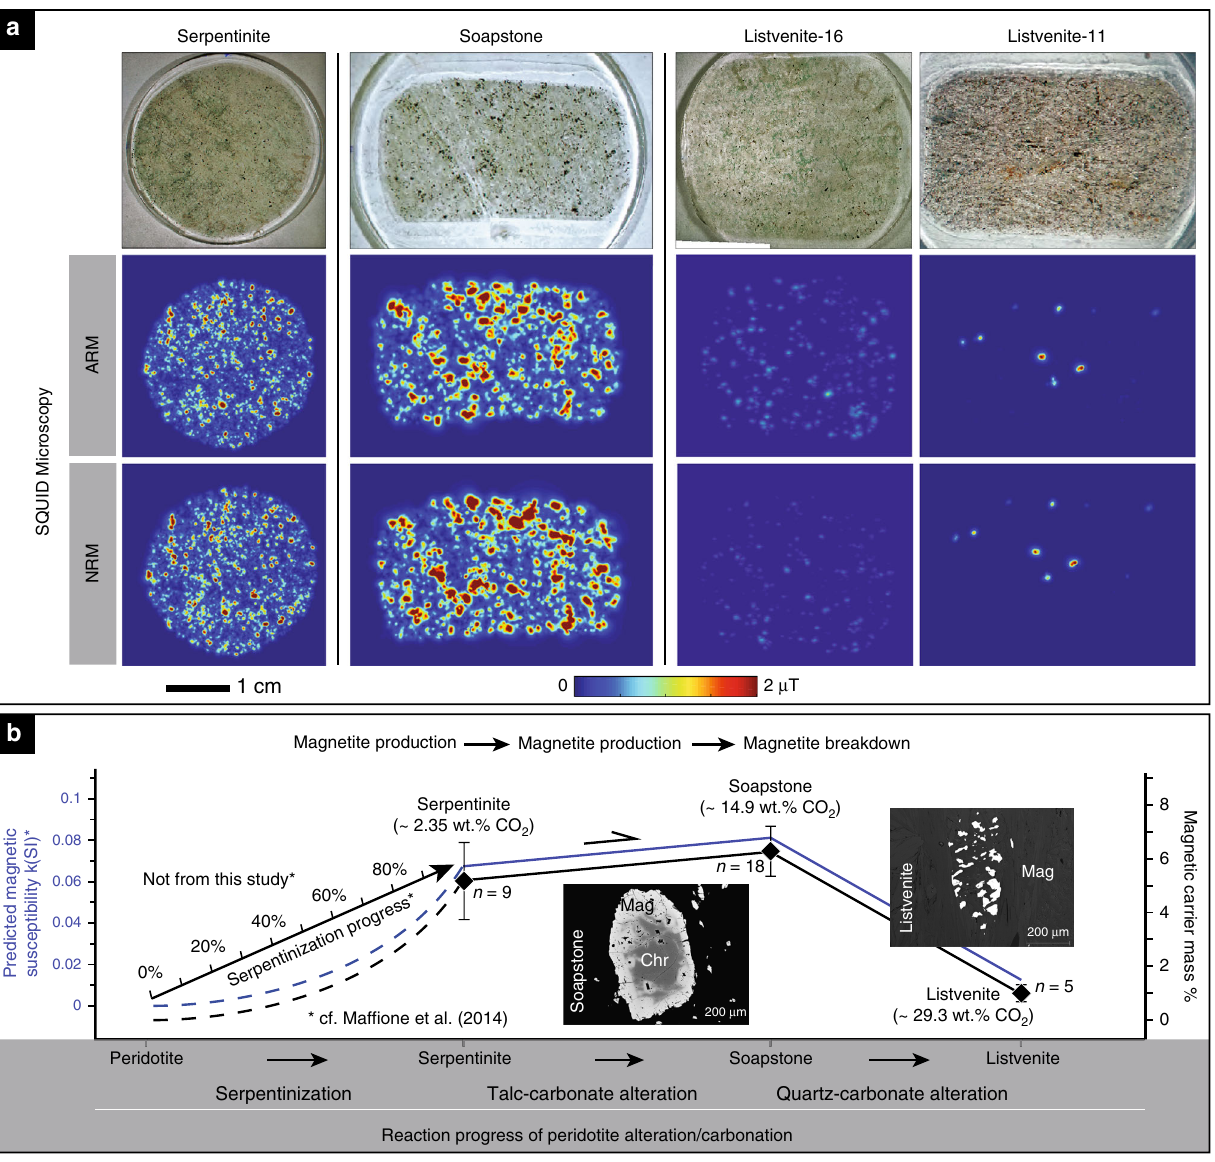
Fig. 7 Thin section magnetic anomaly measurements. a NRM and ARM (with the peak alternating fi eld of 260mT and the DC bias fi eld of 100 μΤ ) in 30 µ m- thickness thin sections of serpentinite, soapstone and two listvenite samples acquired by SQUID microscopy. The samples are mounted on 1-inch discs. Shown is the total magnetic fi eld at a height of 170 µ m above the samples. For comparison, the SQUID images are presented with the color scale of 0 – 2 µ T (Note the grains in the serpentinite and soapstone samples are mostly > 2 µ T). Listvenite samples show signi fi cantly weaker magnetic signal strength compared to serpentinite and particularly soapstone. Relict magnetite grains in the listvenite are mostly present as inclusions in magnesite cores and hence passivated from reaction during listvenite formation. b Schematic of changes in magnetite abundance and predicted magnetic fi eld strength changes versus reaction progress of ultrama fi c rock serpentinization 43 and carbonation. Magnetic susceptibility values are based on Maf fi one et al. 43 and may differ in other alteration settings depending on rock composition and alteration temperature. Diamond symbols show the calculated bulk rock content of magnetite in the different alteration zones assuming bulk rock Fe 3+ is exclusively present in magnetite (Supplementary Table 1). Error bars denote the 1 σ standard deviation of averaged bulk Fe 3+ weight